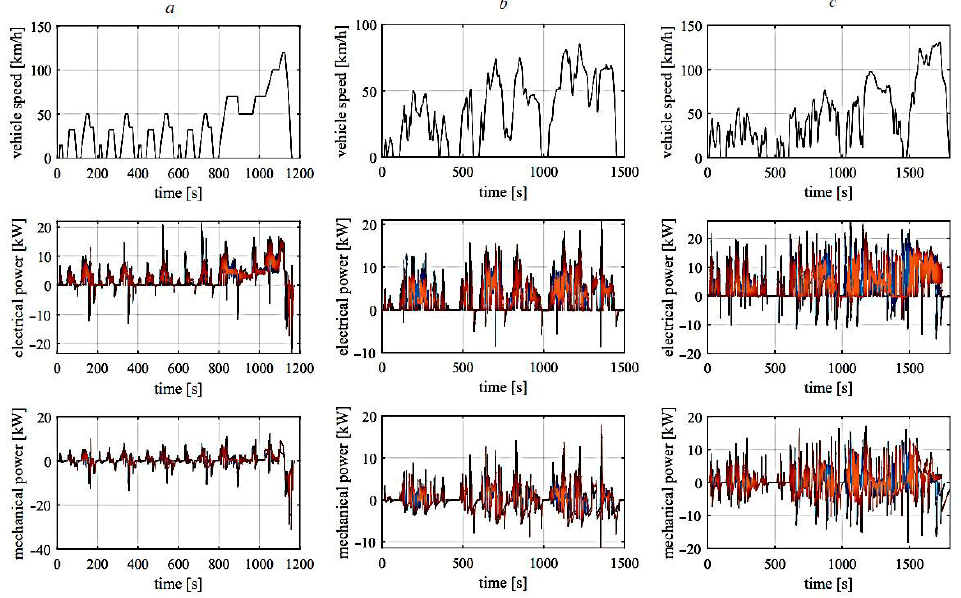
Figure 18. Mechanical, electrical, and power (drive cycles NEDC ( a ), WLTC-2 ( b ), and WLTC-3 ( c )). Final gear ratios are 4.3 (blue) and 3.54 Final gear ratios are 4.3 (blue) and 3.54 (orange).